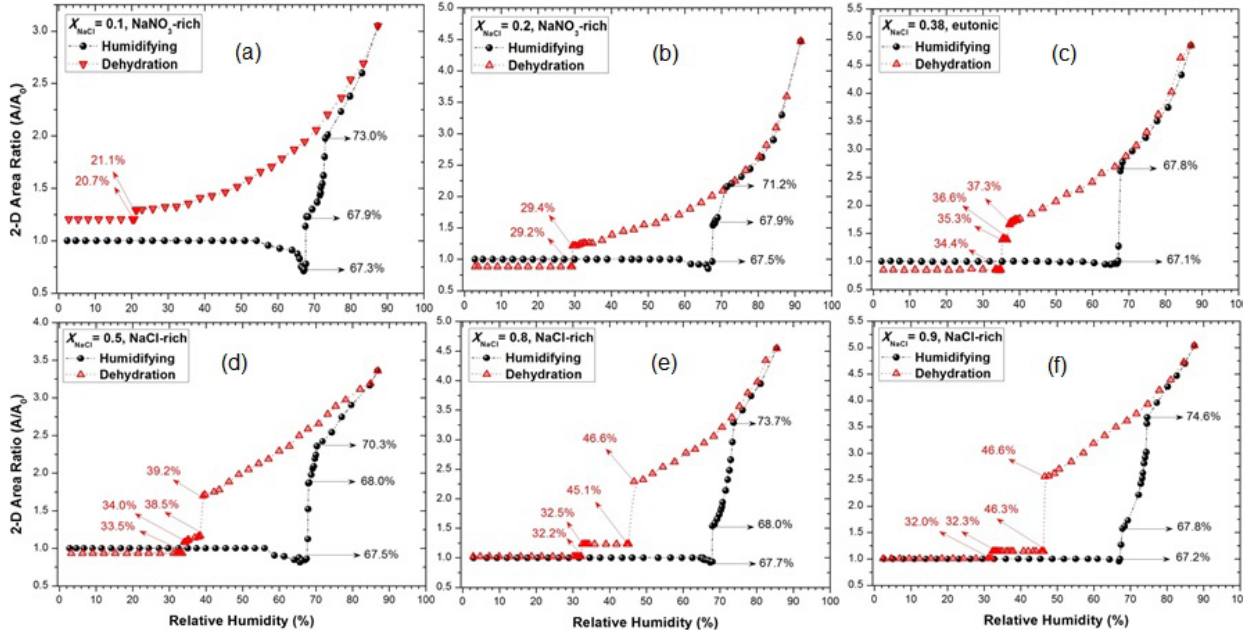
Figure 2. Plots of 2-D projected area ratio as a function of the relative humidity (humidifying process: closed circles; dehydration process: open triangles) for different mole fractions of NaCl–NaNO 3 , expressed in X NaCl values of (a) 0.1 (NaNO 3 -rich), (b) 0.2 (NaNO 3 -rich), (c) 0.38 (eutonic), (d) 0.5 (equimolar/NaCl-rich), (e) 0.8 (NaCl-rich), and (f) 0.9 (NaCl-rich). The transition relative humidity in both humidifying and dehydration processes are marked with